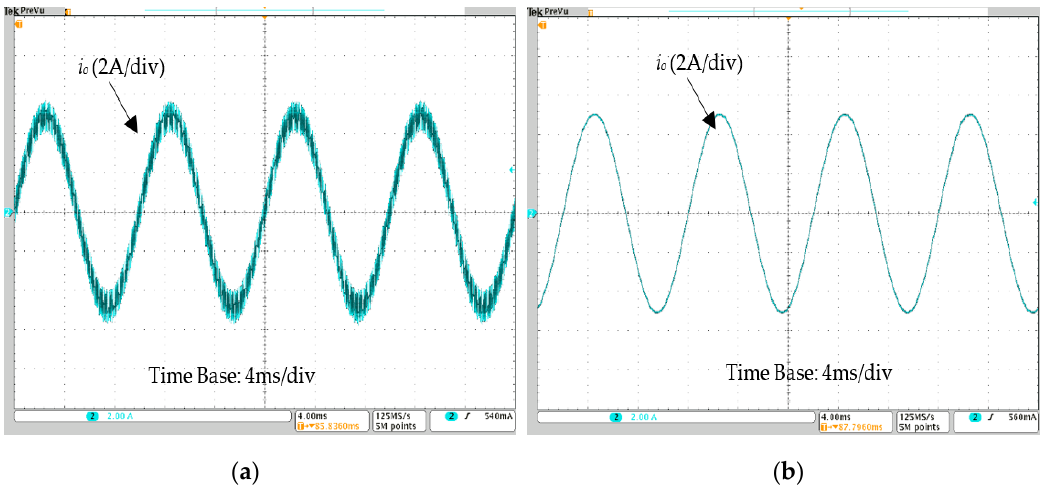
Figure 20. Experimental results of the output current ( a ) without and ( b ) with active damping method.